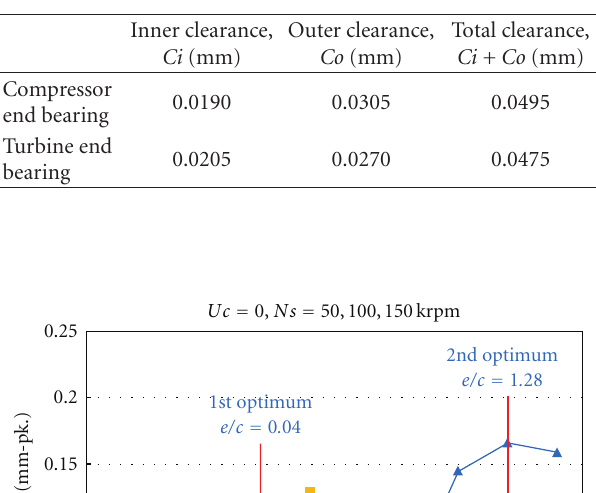
Table 1: Compressor and turbine bearings clearances.